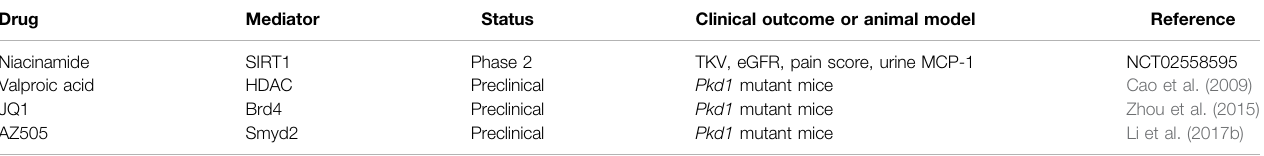
TABLE 2 | Summary of clinical trials and preclinical studies targeting epigenetic factors in ADPKD.